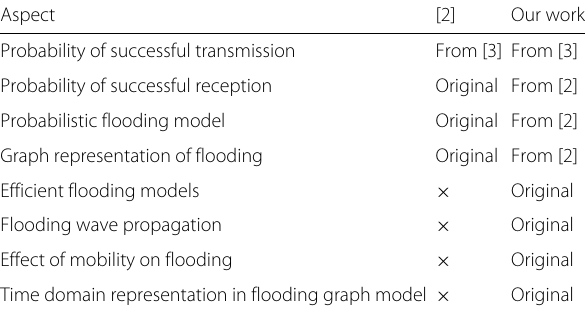
Table 1 Comparison of our work with Viswanath and Obraczka [2]